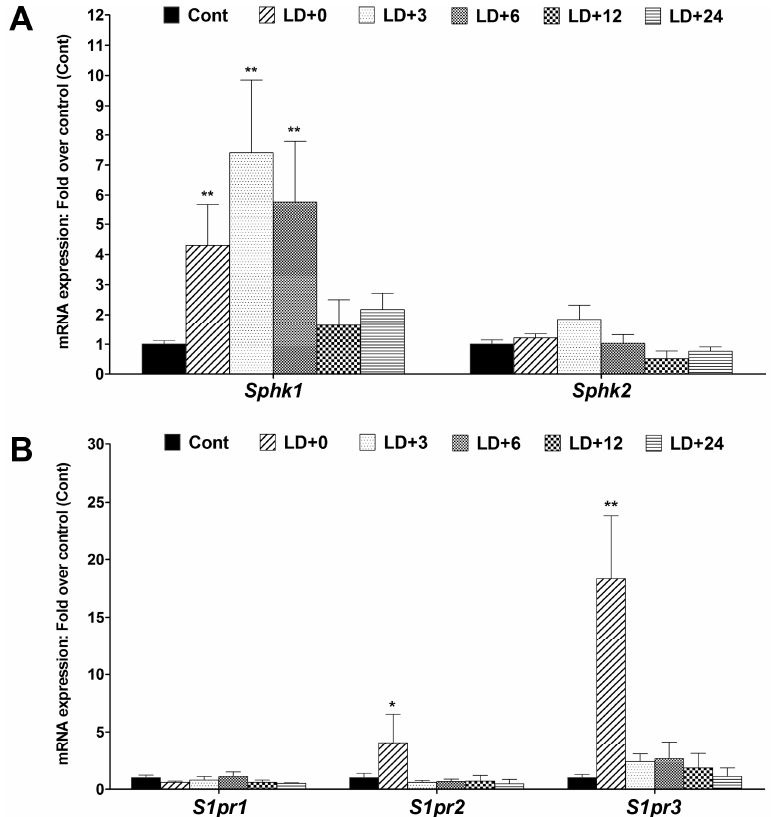
Figure 7. Light stress modulates sphingosine kinase ( Sphk ) 1 and 2 and sphingosine 1-phosphate receptor ( S1pr ) 1, 2 and 3 mRNA expression in adult (2–4 months old) rat retinas. Adult SD rats were exposed to damaging light at an intensity of 2700 lux for 6 h and their retinas were then harvested at different time points after light damage: 0 h (LD + 0), 3 h (LD + 3), 6 h (LD + 6), 12 h (LD + 12) and 24 h (LD + 24). Harvested samples were prepared for RNA extraction and subsequent qRT-PCR. ( A ) mRNA expression of Sphk1 and Sphk2 were presented as fold over control. ( B ) mRNA expression of S1pr1 , S1pr2 and S1pr3 presented as fold over control. The expression data were calculated by dCt methods and compared to the expression of control housekeeping genes. The data presented are the mean of three independent experiments ( ±